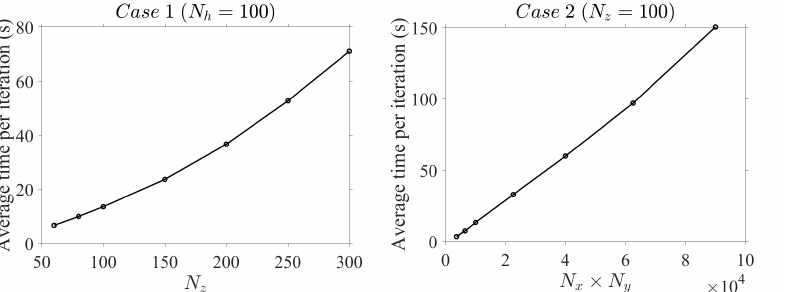
Figure 8. Average computer time per iteration for calculating six magnetic gradient components and three magnetic field components in case 1 and case